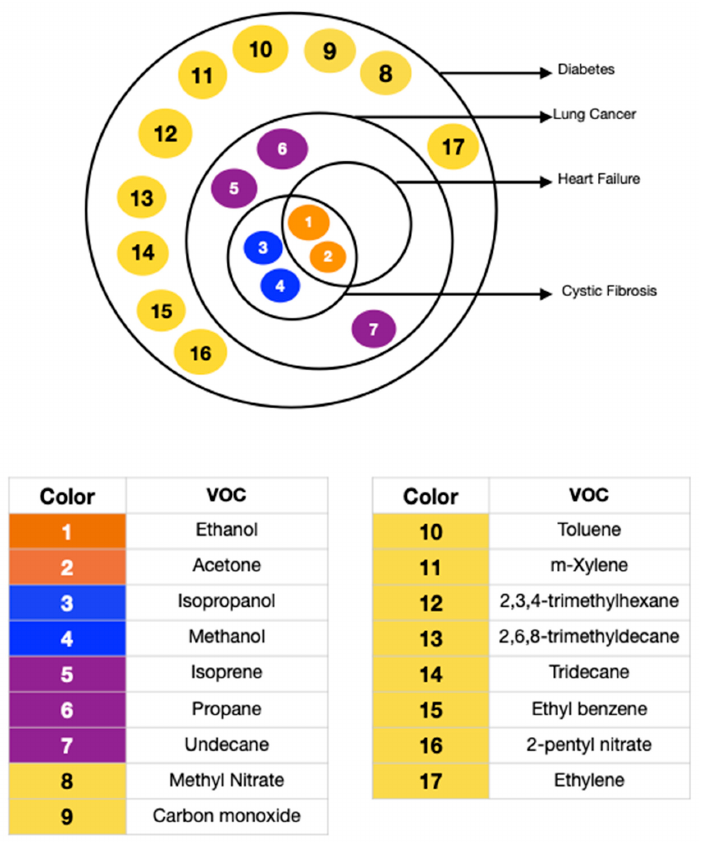
Figure 3. Breath Biomarkers associated with Diabetes (8–17 yellow) and overlapping with Lung Cancer (5–7 purple), Heart Failure (1–2 orange), and Cystic Fibrosis (1–2 orange and 3–4 blue). Table 2. Diseases with Breath Biomarkers Overlapping with Diabetes Breath Biomarkers.